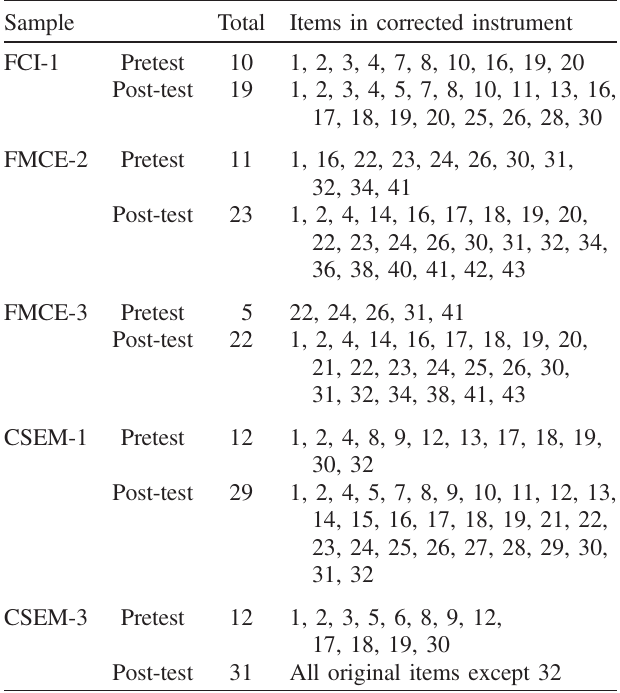
TABLE I. Corrected pretest and post-test items. The items included on the corrected instruments. Sample Total Items in corrected instrument